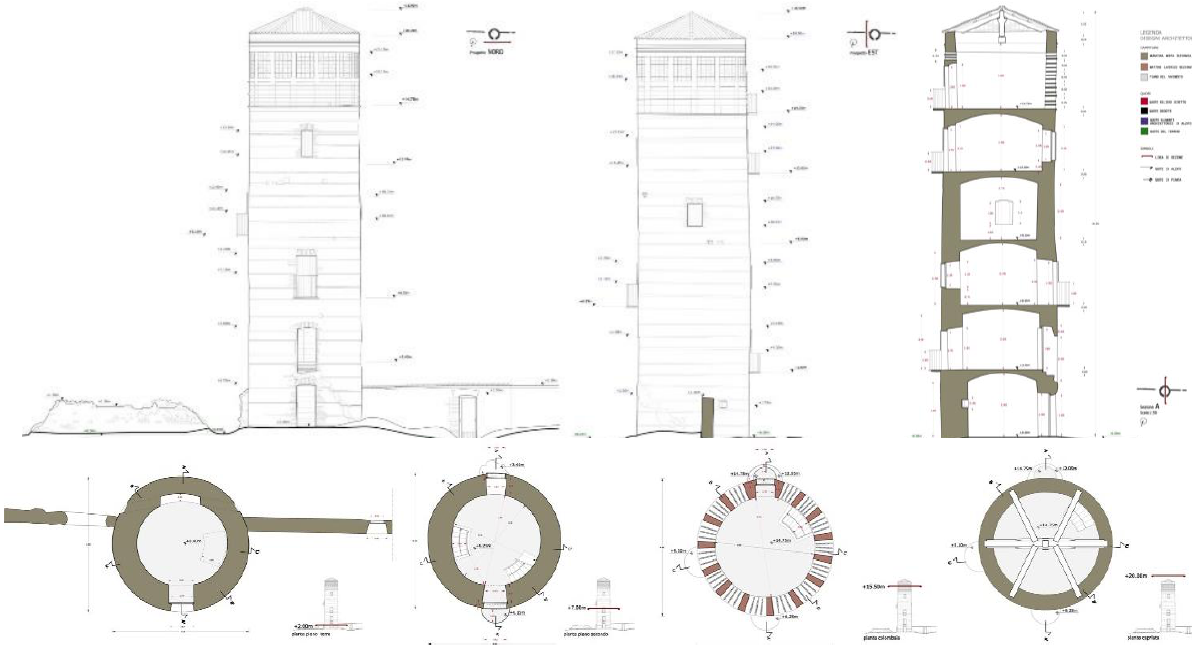
Figure 2. (Below) (a) The North and the East side of the tower; (right) the N-S section; (b) Representation of some of the tower plans: (from left) ground floor; second floor; dovecot level; circular roof structure. (Original scale